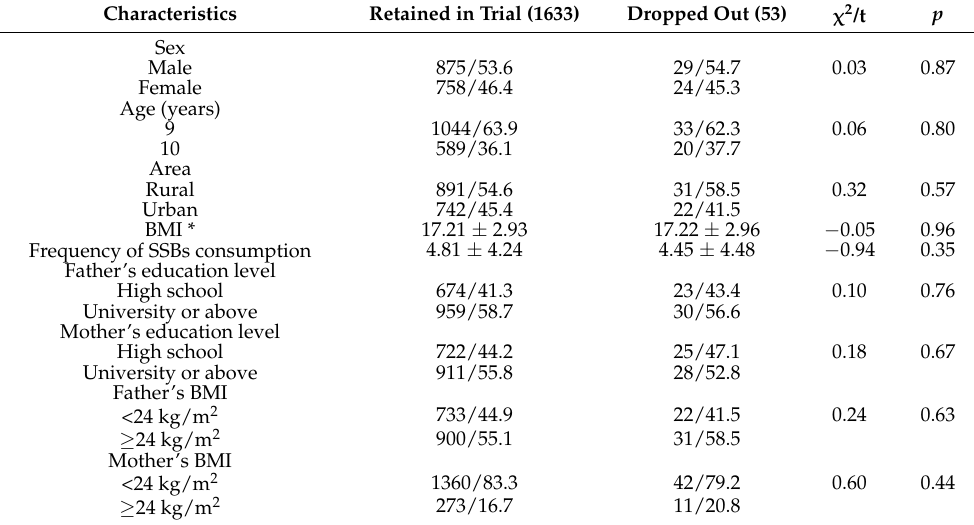
Table 1. Demographic characteristics between subjects retained in trial and dropped out (N/%, Mean ±